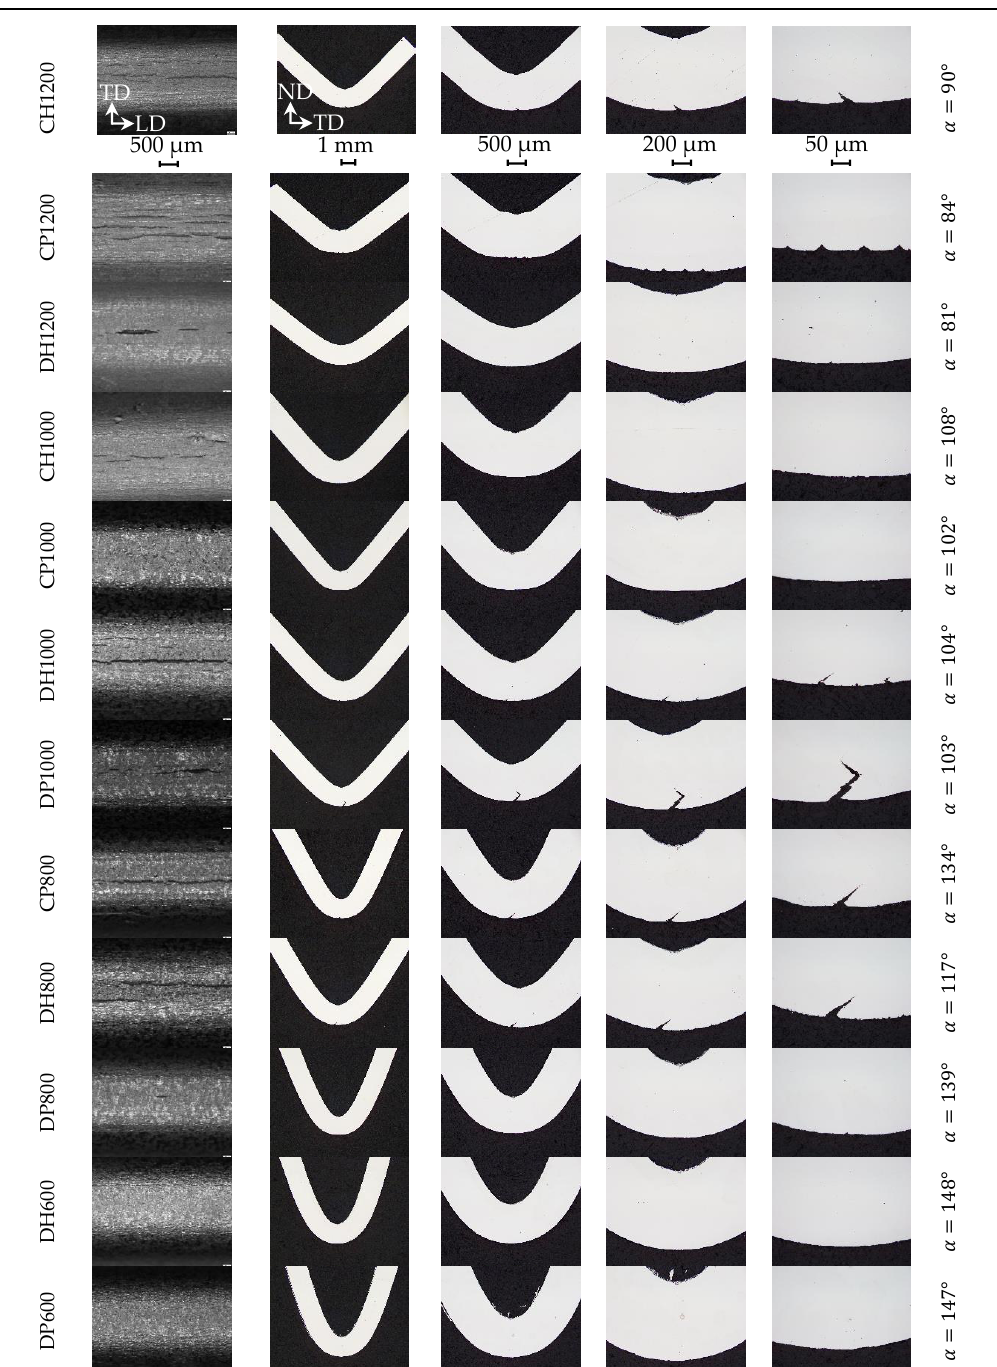
Molecules 2018 , 23 , x Table A5. Micrographs of bending specimens (LD). Table A5. Micrographs of bending specimens